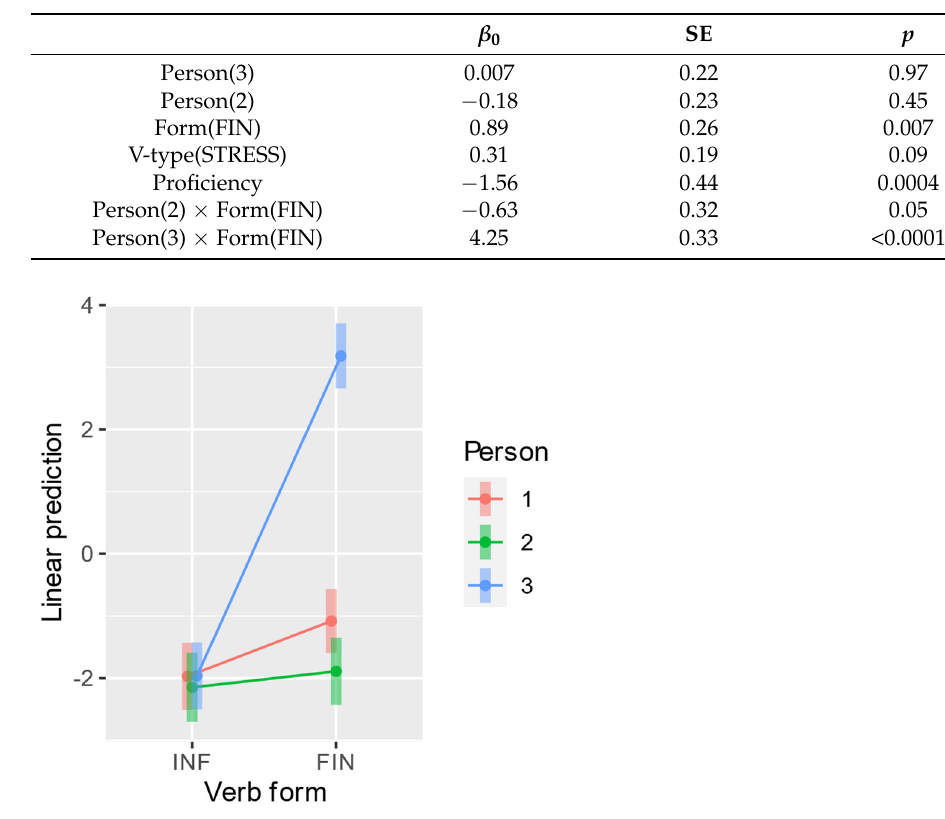
Table 6. Model parameters (Person, Form, Frequency, V-type and Proficiency).